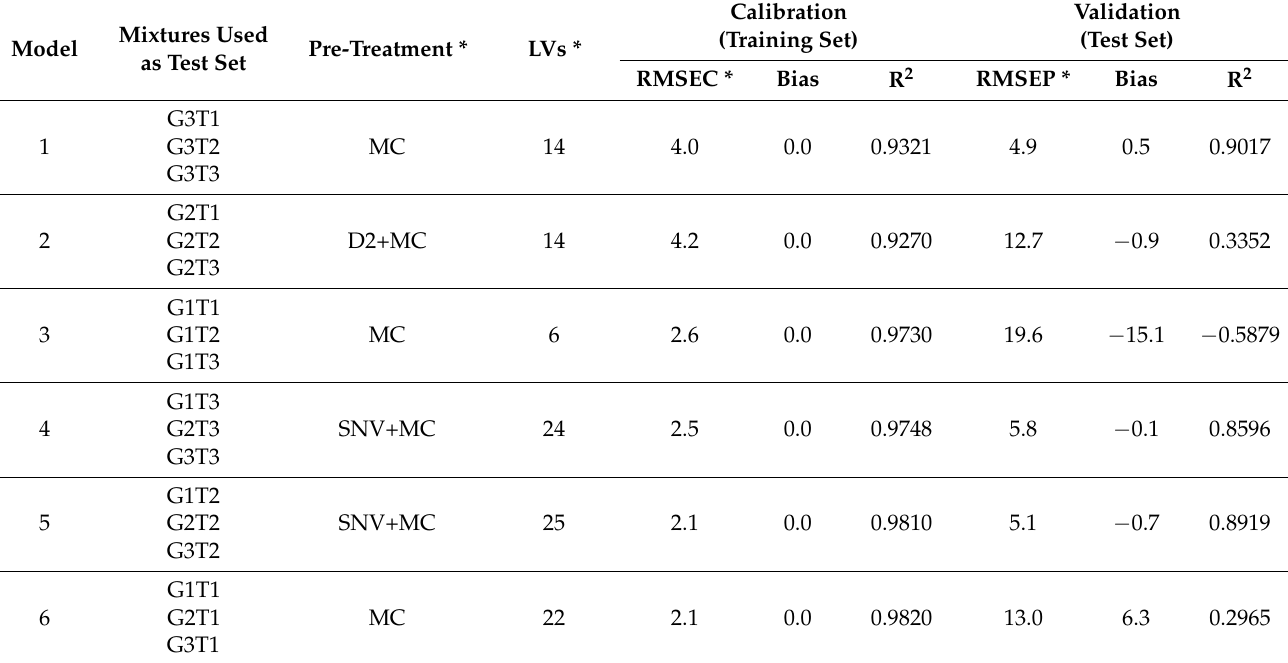
Table 2. Results of PLS calibration for the quantification of the alprazolam concentration in spiked